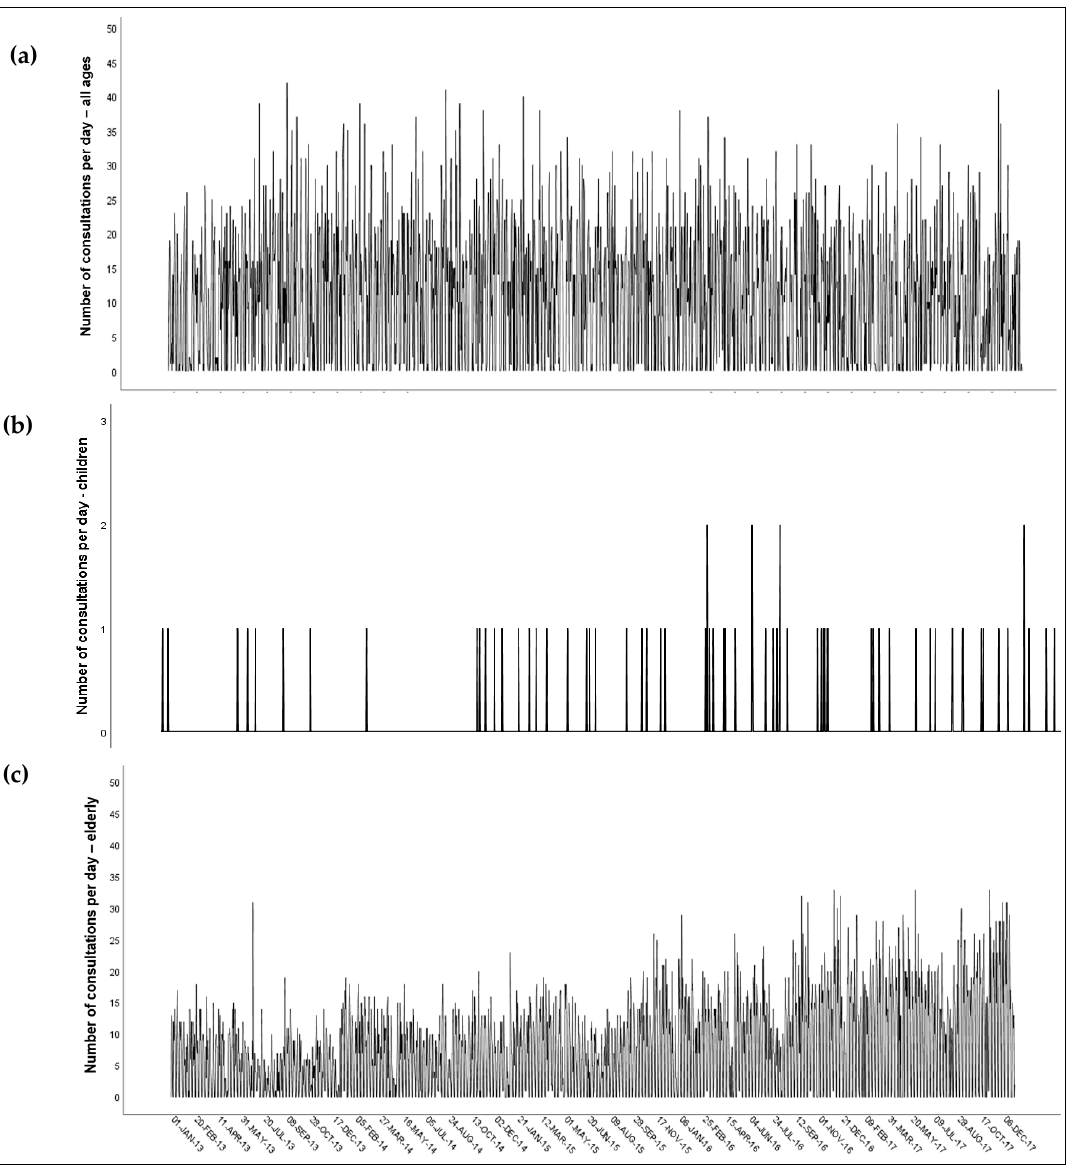
Figure 2. Temporal variability of the daily number of consultations due to diabetes mellitus: ( a ) all age groups; ( b ) children; ( c ) the elderly in the MOL, Slovenia between 1 January 2013 and 31 December 2017.